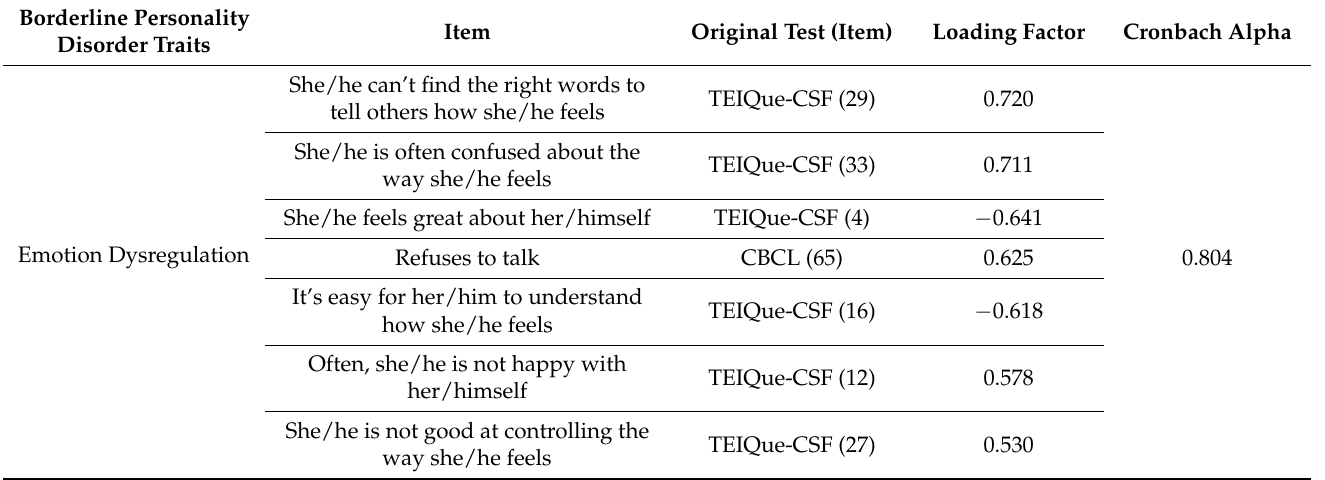
Table 2. Borderline personality trait